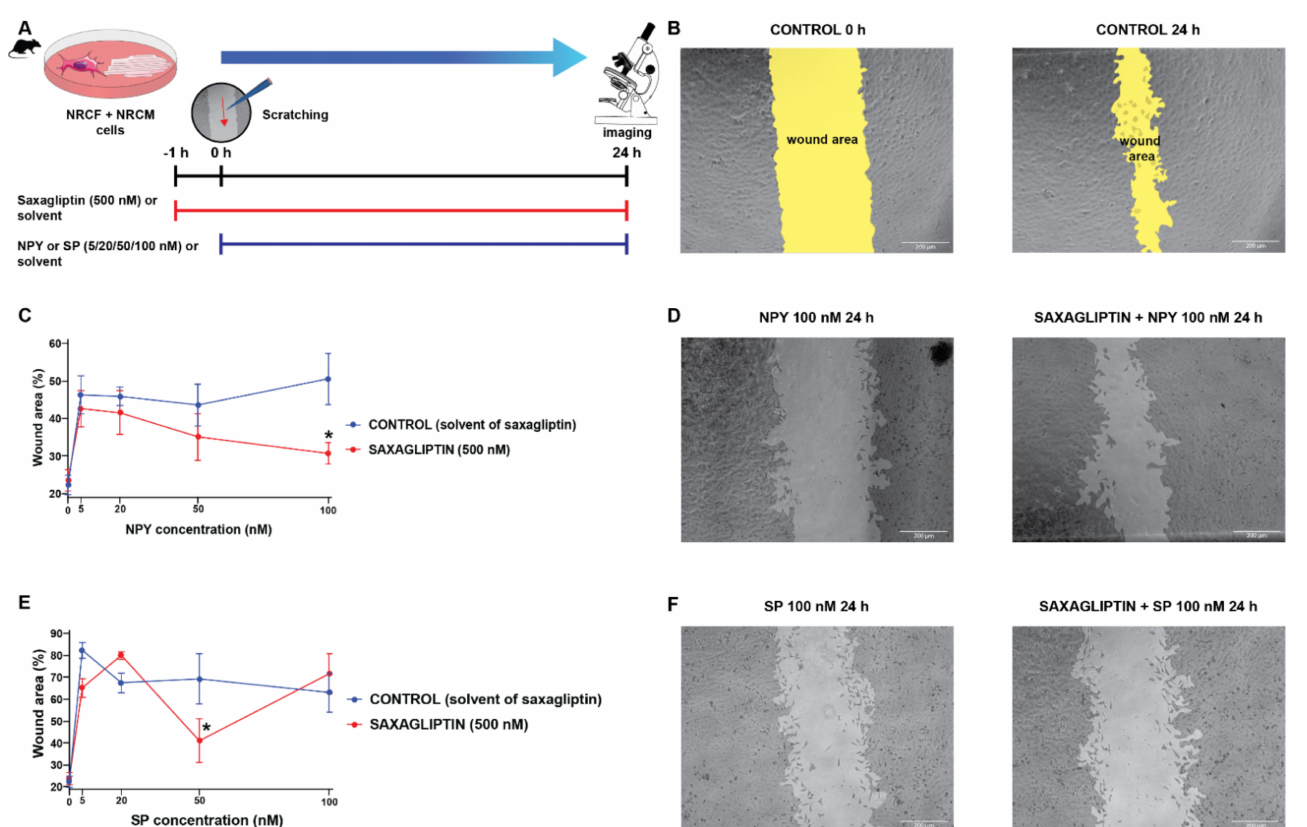
Figure 5. The cell migration speed in saxagliptin- and neuropeptide-treated cardiomyocyte/fibroblast co-culture model. Scratch assay treatment protocol ( A ) and the results of the treatment with NPY ( C ) and SP ( E ). Representative bright field microscope images of control ( B ), NPY-treated ( D ), and SP-treated groups ( F ). Two-way ANOVA, * p < 0.05 vs. CON. Group sizes: n = 8–22 from 3–5 independent experiments. Data are presented as mean ± SEM in percentage of the wound area compared to each corresponding 0 h (baseline)